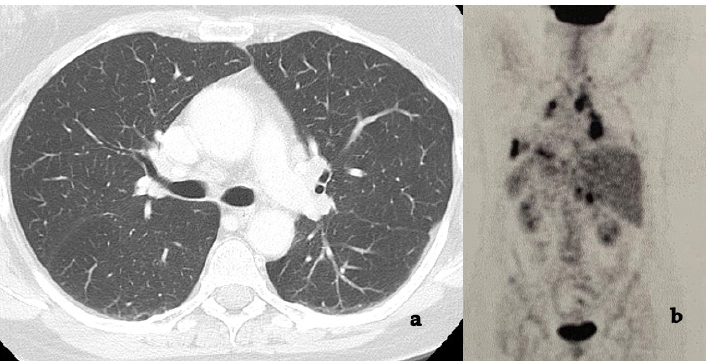
Figure 12. HRCT (enlargement of hilar lymph nodes) ( a ) and total body 18F-FDG PET (multiple areas of increased uptake corresponding to regions of active disease) ( b ).